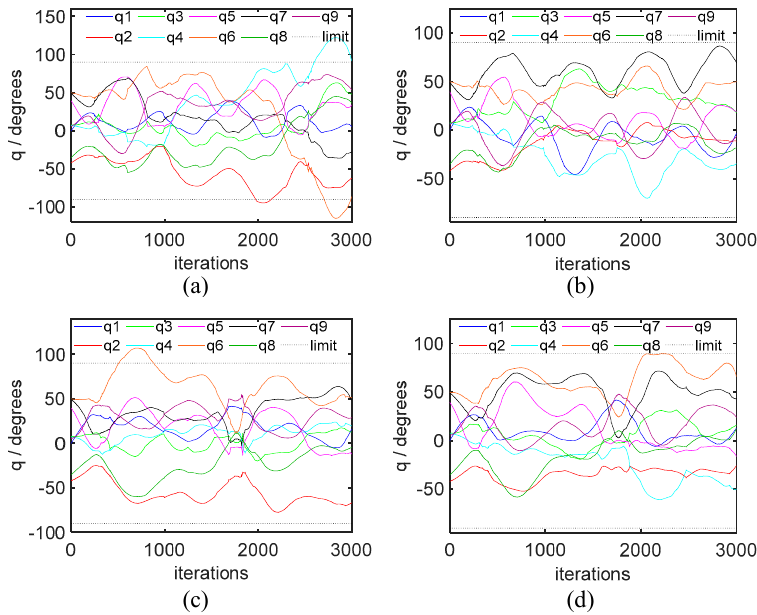
Figure 10. Joint angle of the manipulator in different paths. ( a ) Unlimited joint angles of the manipulator in a double leaf rose path. ( b ) Limited joint angles of the manipulator in a double leaf rose path. ( c ) Unlimited joint angles of the manipulator in atriple leaf rose path. ( d ) Limited joint angles of the manipulator in a triple leaf rose path.